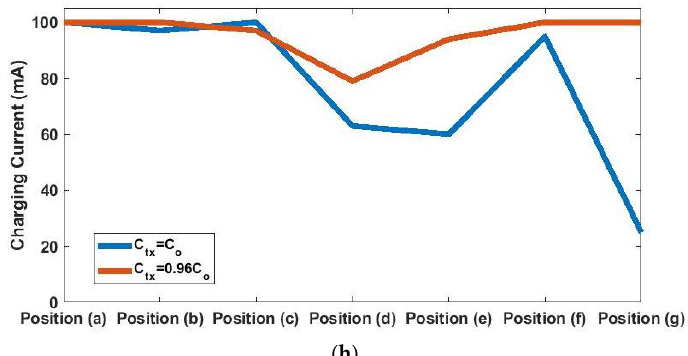
Figure 24. Measuring wireless-charging hanger system with different hanging scenarios: ( a ) garment in neutral position; ( b ) garment slides to left arm; ( c ) garment falls off left arm; ( d ) garment slides to right arm; ( e ) garment falls off right arm; ( f ) garment pulled from front side; ( g ) garment pulled from back side; ( h ) measured charging current with different C tx